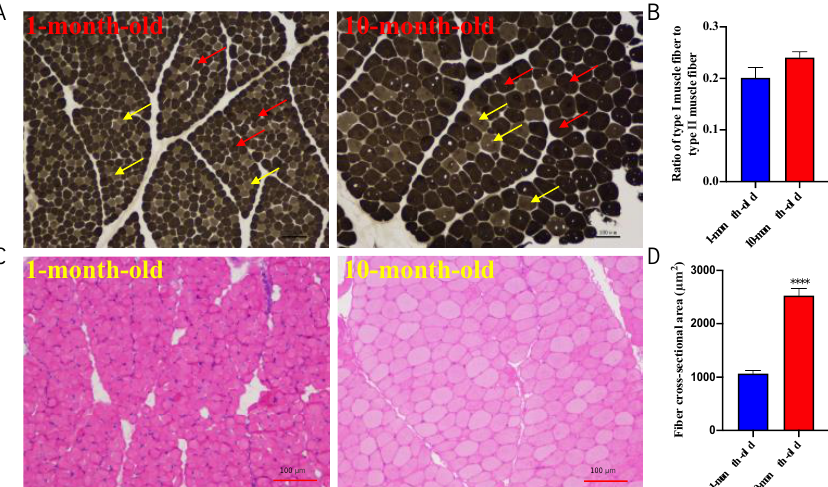
Figure 1. The characteristic of muscle fibers for longissimus dorsi between 10-month-old and 1-month-old Longlin goat. ( A ) ATPase staining of longissimus dorsi between 10-month-old and 1-month-old Longlin goat. Type I is light gray or colorless (yellow arrow), type II is dark gray or black (red arrow). ( B ) Statistics of fiber types for longissimus dorsi between 10-month-old and 1-month-old Longlin goat. ( C ) H&E staining of longissimus dorsi between 10-month-old and 1-month-old Longlin goat. ( D ) Statistics of fiber cross-sectional area for longissimus dorsi between 10-month-old and 1-month-old Longlin goat. H&E staining: hematoxylin-eosin staining; ATPase Staining: Adenosine Triphosphatase Staining.